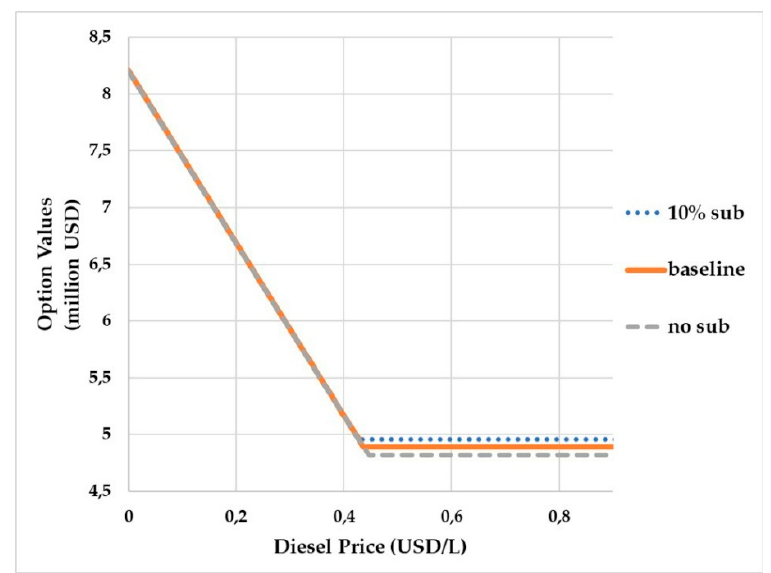
Figure 6. Option values at different government subsidies for investment in the e-jeepney. Baseline = 5% subsidy; 10% sub = 10% subsidy; no sub = removal of subsidy. Optimization results are tabulated in Supplementary Material Table S7.